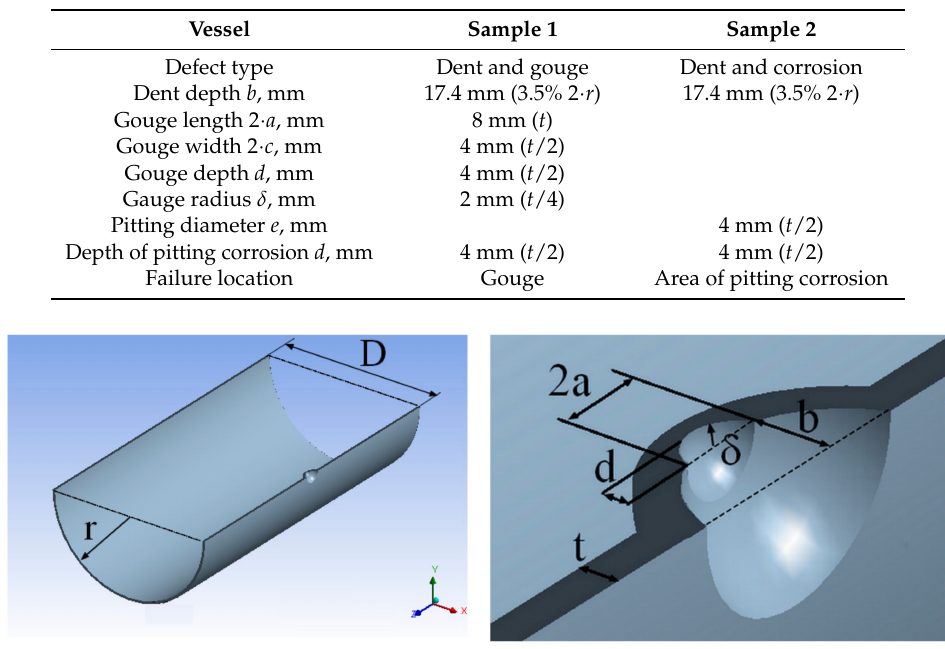
Table 3. Characteristics of the combined defects.